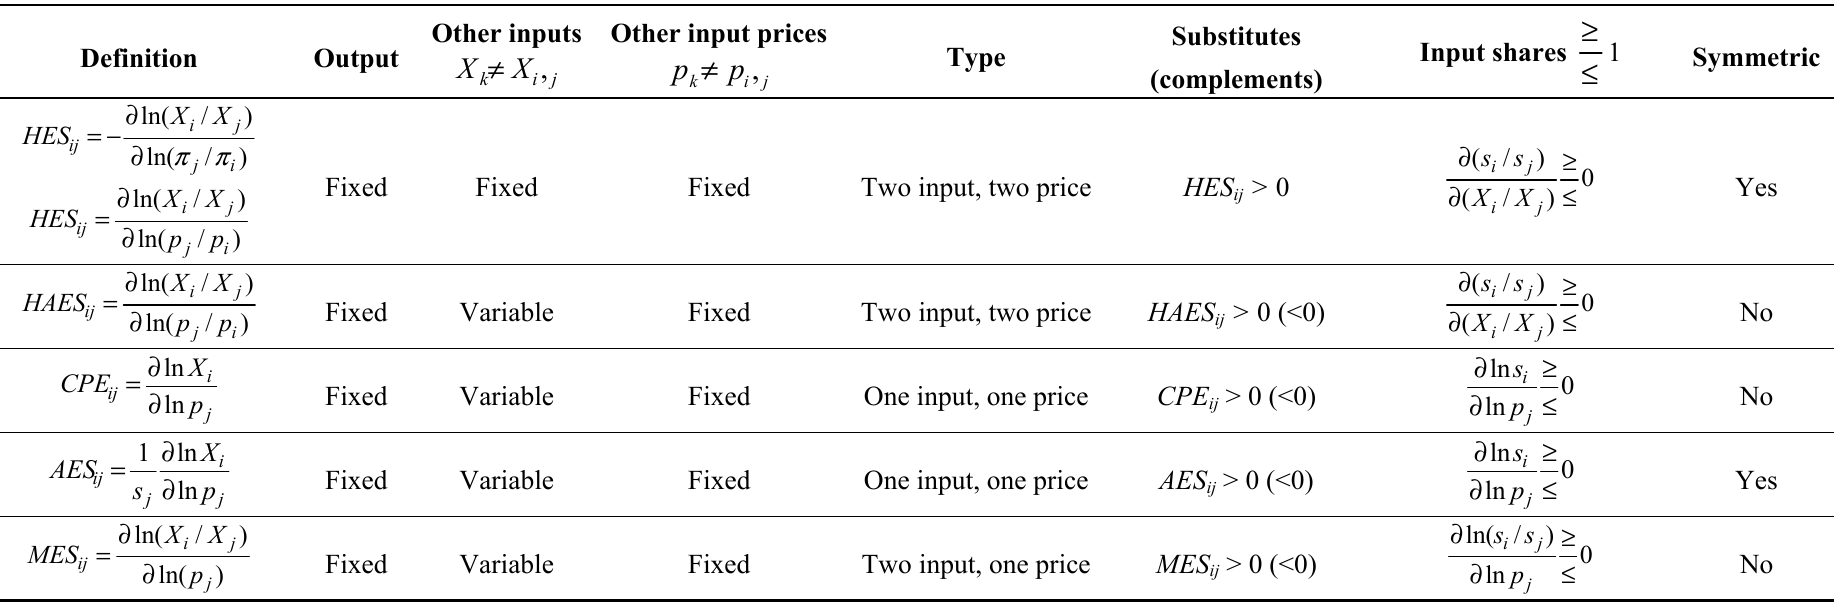
Table 1. Comparing common definitions of substitution elasticities. Source: Broadstock et al.